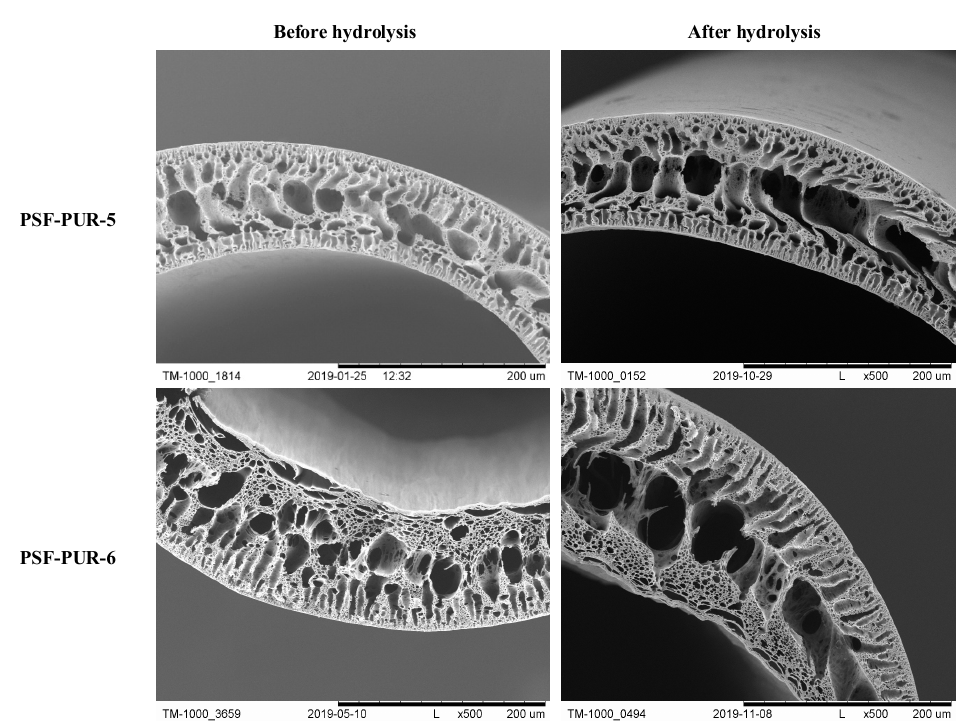
Figure 7. The crosssection and part of the crosssection of the PSF-PUR-3 and PSF-PUR-4 membranes before and after hydrolysis.